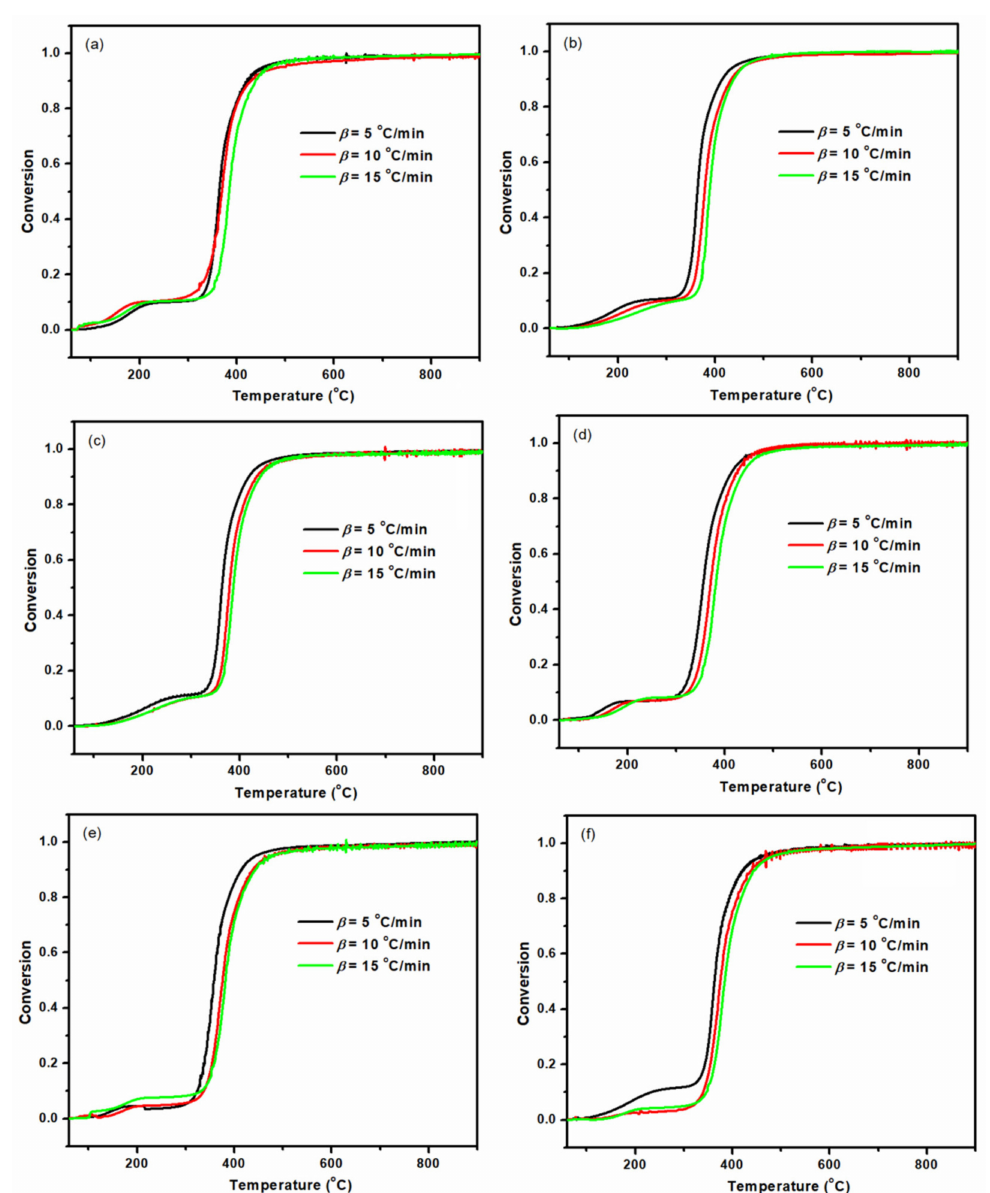
Figure 13. The variation of α in terms of temperature for the studied samples at varied β , EP/Mica–0.5 ( a ), EP/Mica–2 ( b ), EP/Mica–5 ( c ), EP/Mica–IM–0.5 ( d ), EP/Mica–IM–2 ( e ), and EP/Mica–IM–5 ( f )